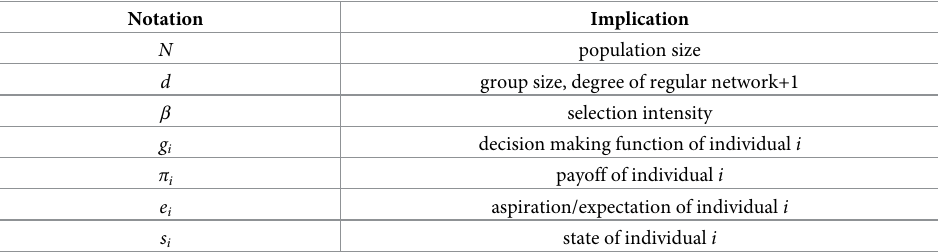
Table 2. Notation